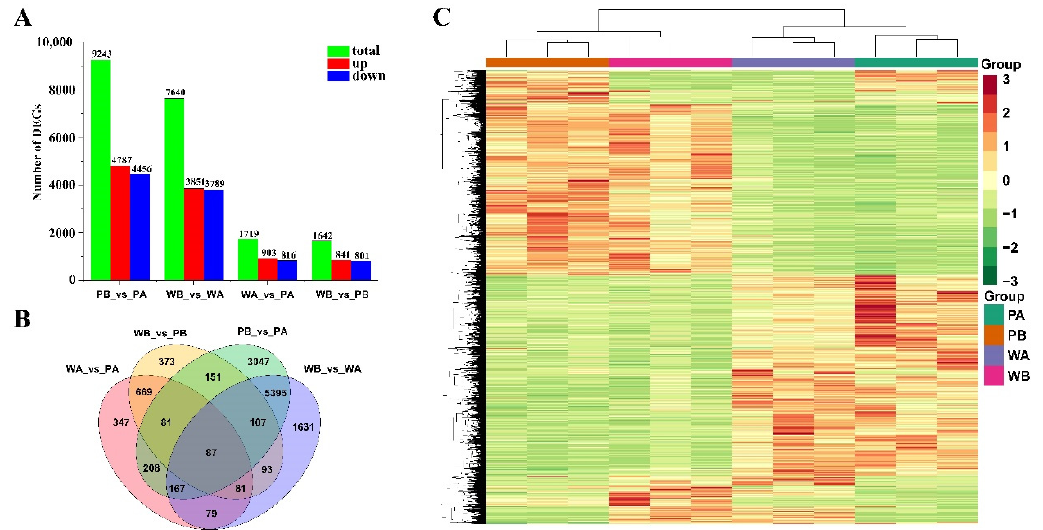
Figure 3. Differential genes (DEGs) analysis of petals of different colors and regions. ( A ) Numbers of DEGs in pairwise comparisons of the four libraries. ( B ) Venn diagram showing DEG distributions. ( C ) Expression profile clustering of different samples. The color scale on the right represents re-processed log10 (FPKM+1) using heatmap, representing the relative expression level. The expression variance for each gene is indicated by different colors ranging from low (green) to high (red). PA, PB, WA, and WB represent the spot region and non-spot region of PF and X74 petals, respectively.